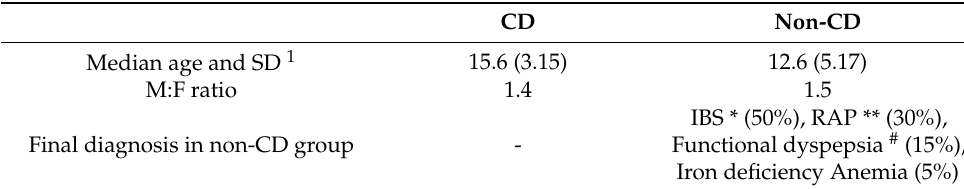
Table 1. Demographic and baseline features in CD and non-CD